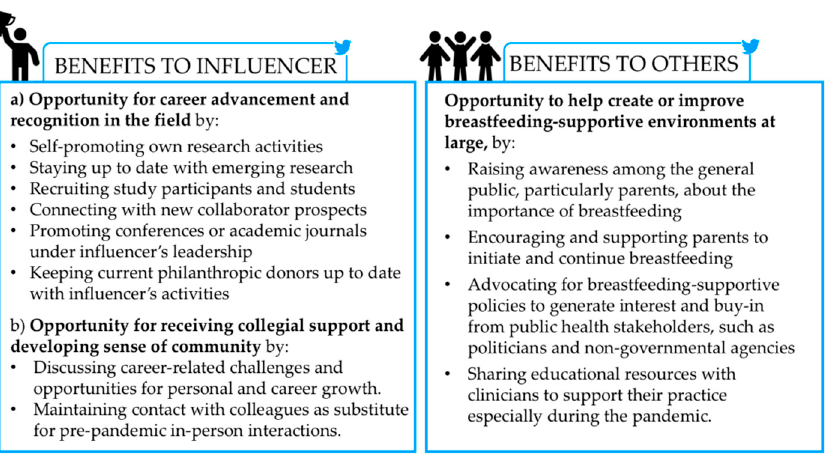
Figure 3. Summary of influencers’ motivations and goals when tweeting about breastfeeding. Legend: Images titled Winner ( left ) and People ( right ) by Wardehpillai and Tuk Tuk Design, respectively, from the Noun Project. Note that whether these benefits are conferred is beyond the scope of this manuscript.